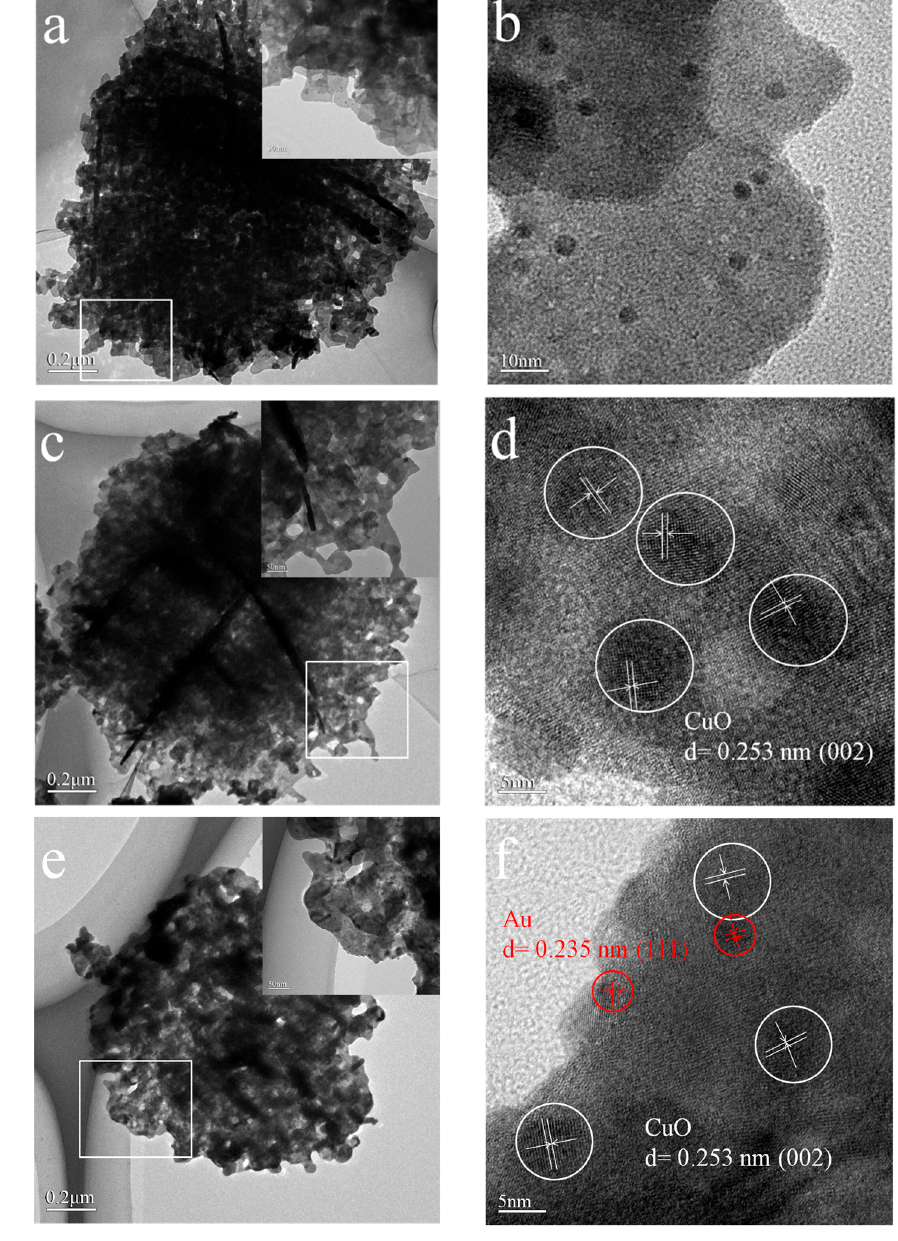
Figure 3. TEM images of the Au/Bi 2 WO 6 ‐ 400 (calcinated at 300 °C): Au 1.30 wt % ( a , b ); CuO/Bi 2 WO 6 ‐ 400: Cu 5.10 wt % ( c , d ) and Au – CuO/Bi 2 WO 6 ‐ 400: Cu 4.85 wt %, Au 0.438 wt % ( e , f ).